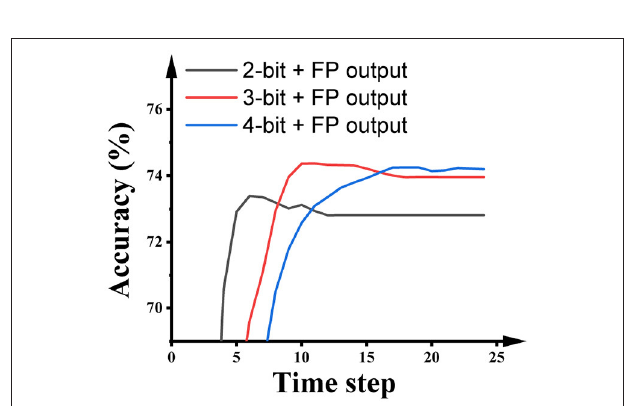
FIGURE 7 | The impact of the activation precision in hidden layers during the quantization training of ResNet-50 on the performance of SNNs on